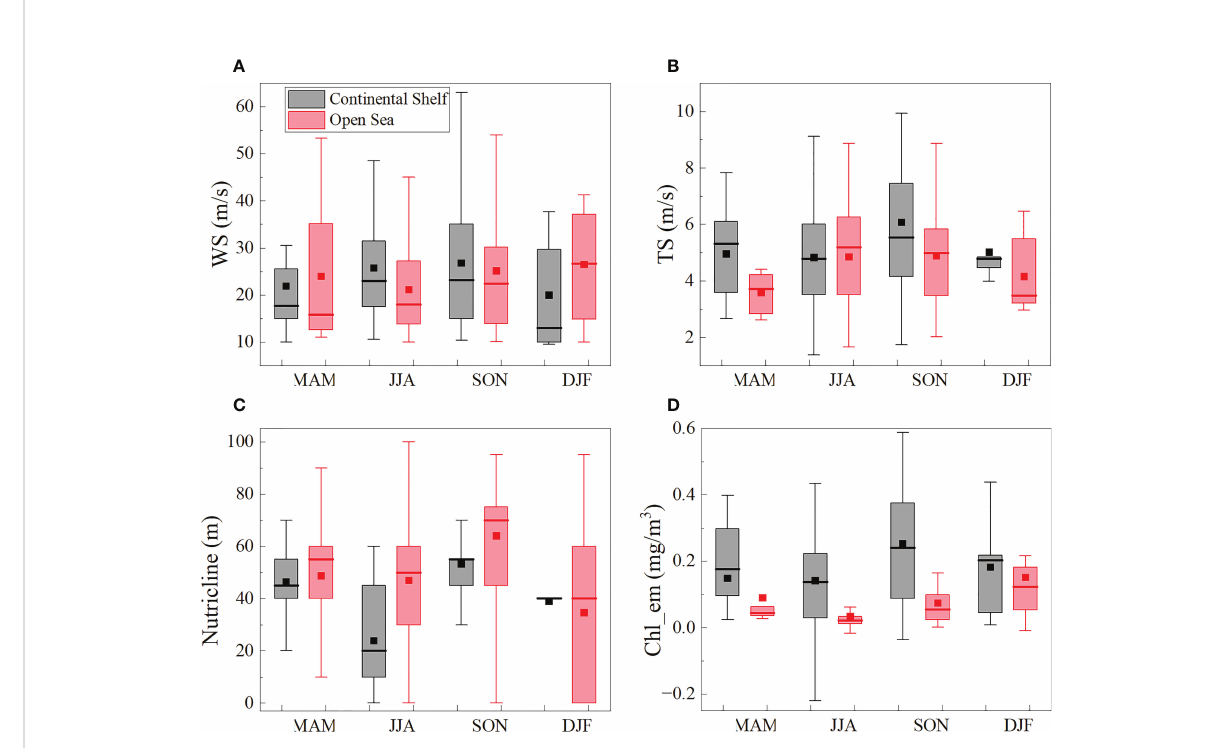
values from the lower to upper quartile (25 to 75 percentile). The middle line represents the median. The horizontal line extends from the minimum to the maximum value. The rectangular point represents the